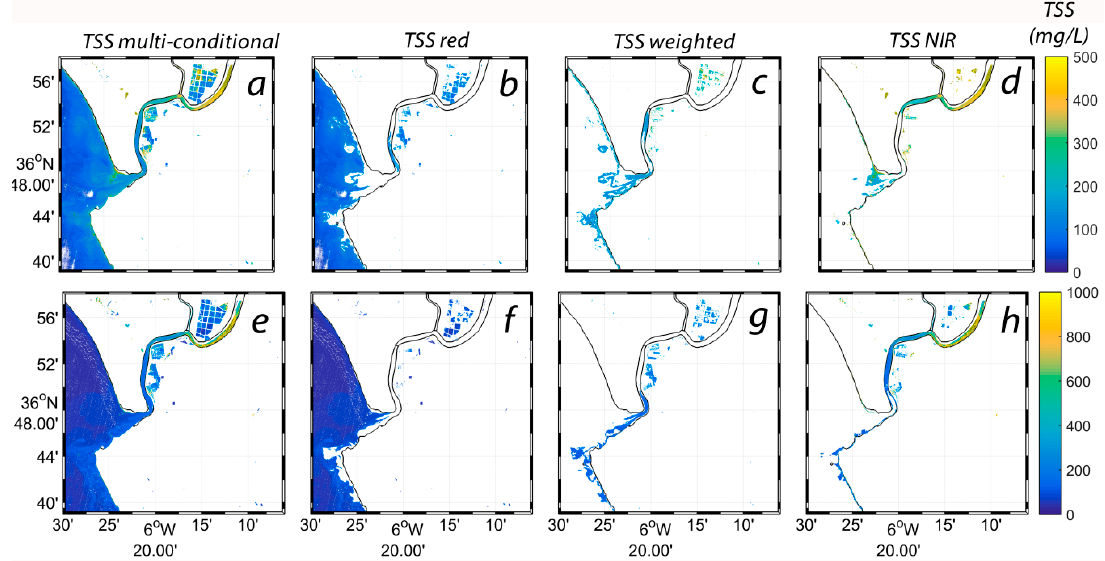
Figure 10. Total Suspended Solids (TSS) concentration (mg/L) derived from the multi-conditional algorithm for Sentinel-2 imagery using the red (664 nm) and near-infrared NIR (865 nm) bands after correction with ACOLITE (10 m spatial resolution) in the Guadalquivir estuary on 19 December 2015 ( a – d ) and on 17 February 2016 ( e – h ). Note different ranges in the color bar (TSS concentration).